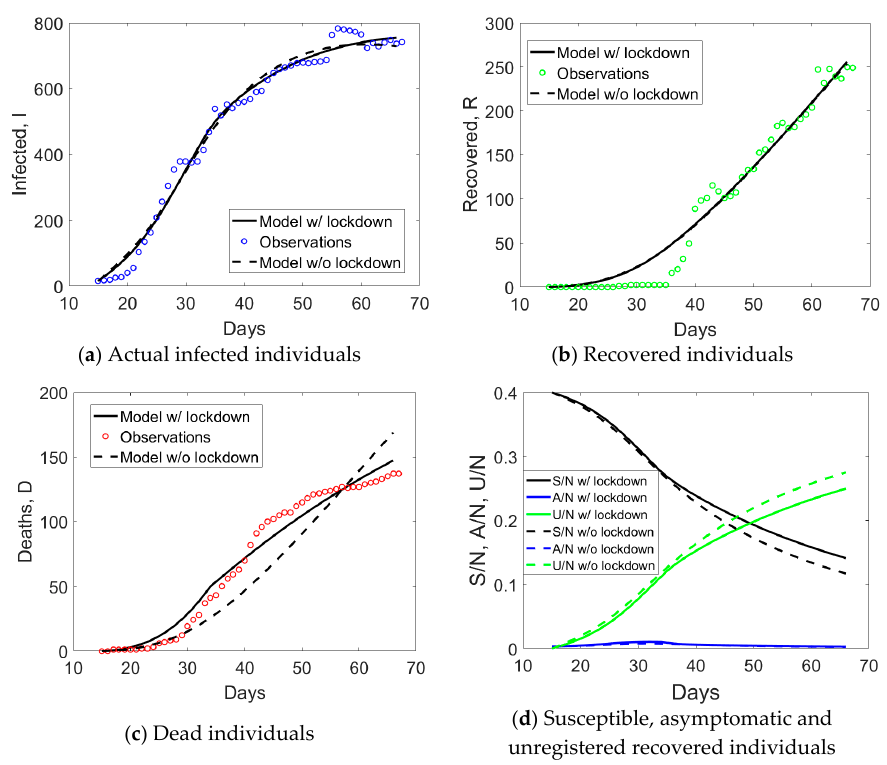
Figure 9. Simulated compartments including or excluding lockdown measures in the model, with time-dependent or time-independent parameters, for Valle d’Aosta.